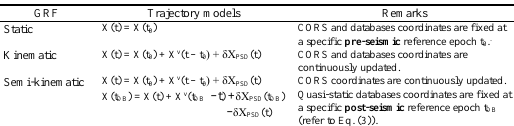
Table 2. Types of geodetic reference frames in relation to the time- dependent